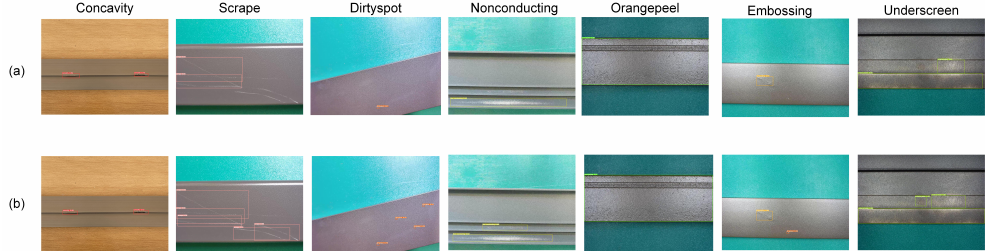
Figure 11. PR-Cure comparison of YOLOv5 and MS-YOLOv5 for seven different defects.